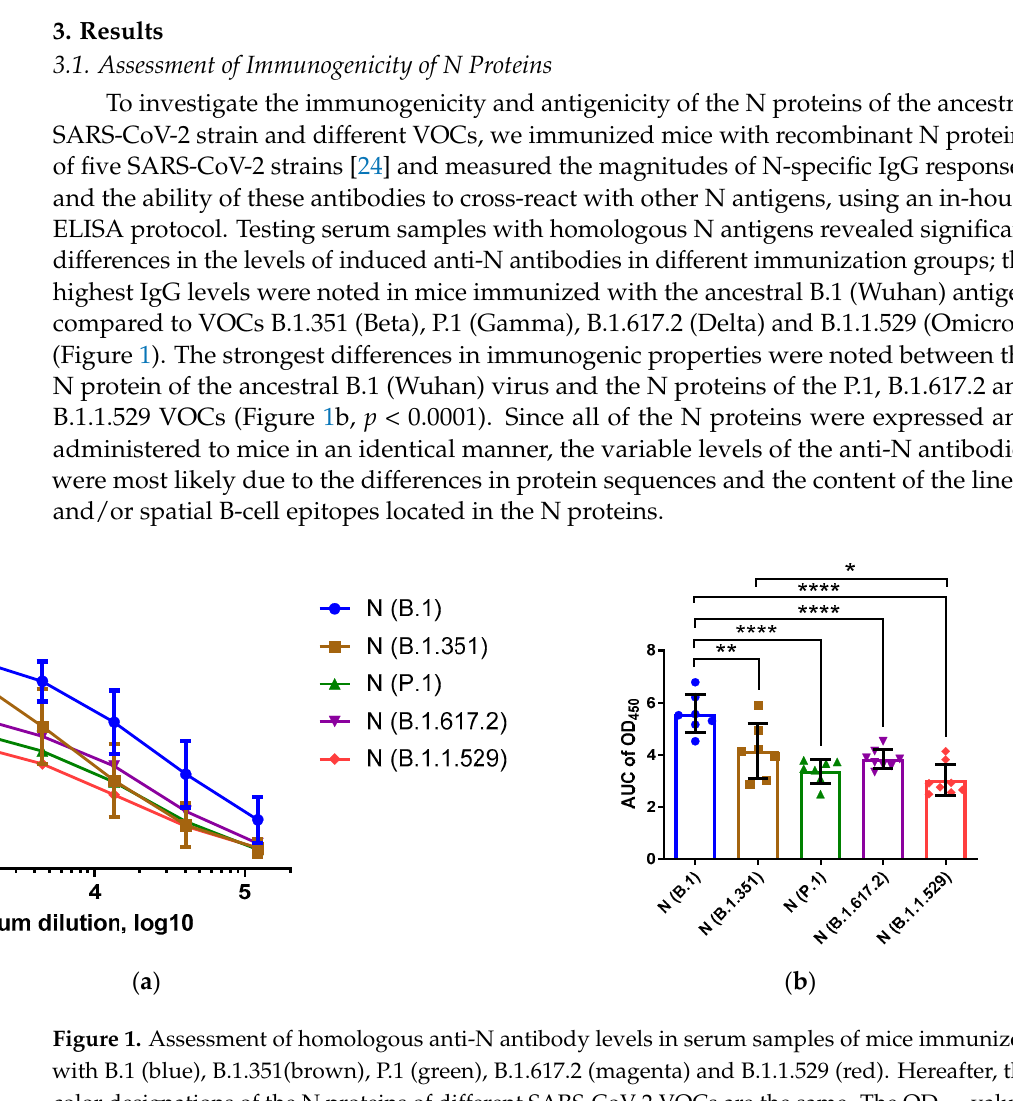
each N protein, against all five recombinant N antigens: B.1 (Wuhan), B.1.351 (Beta), P.1